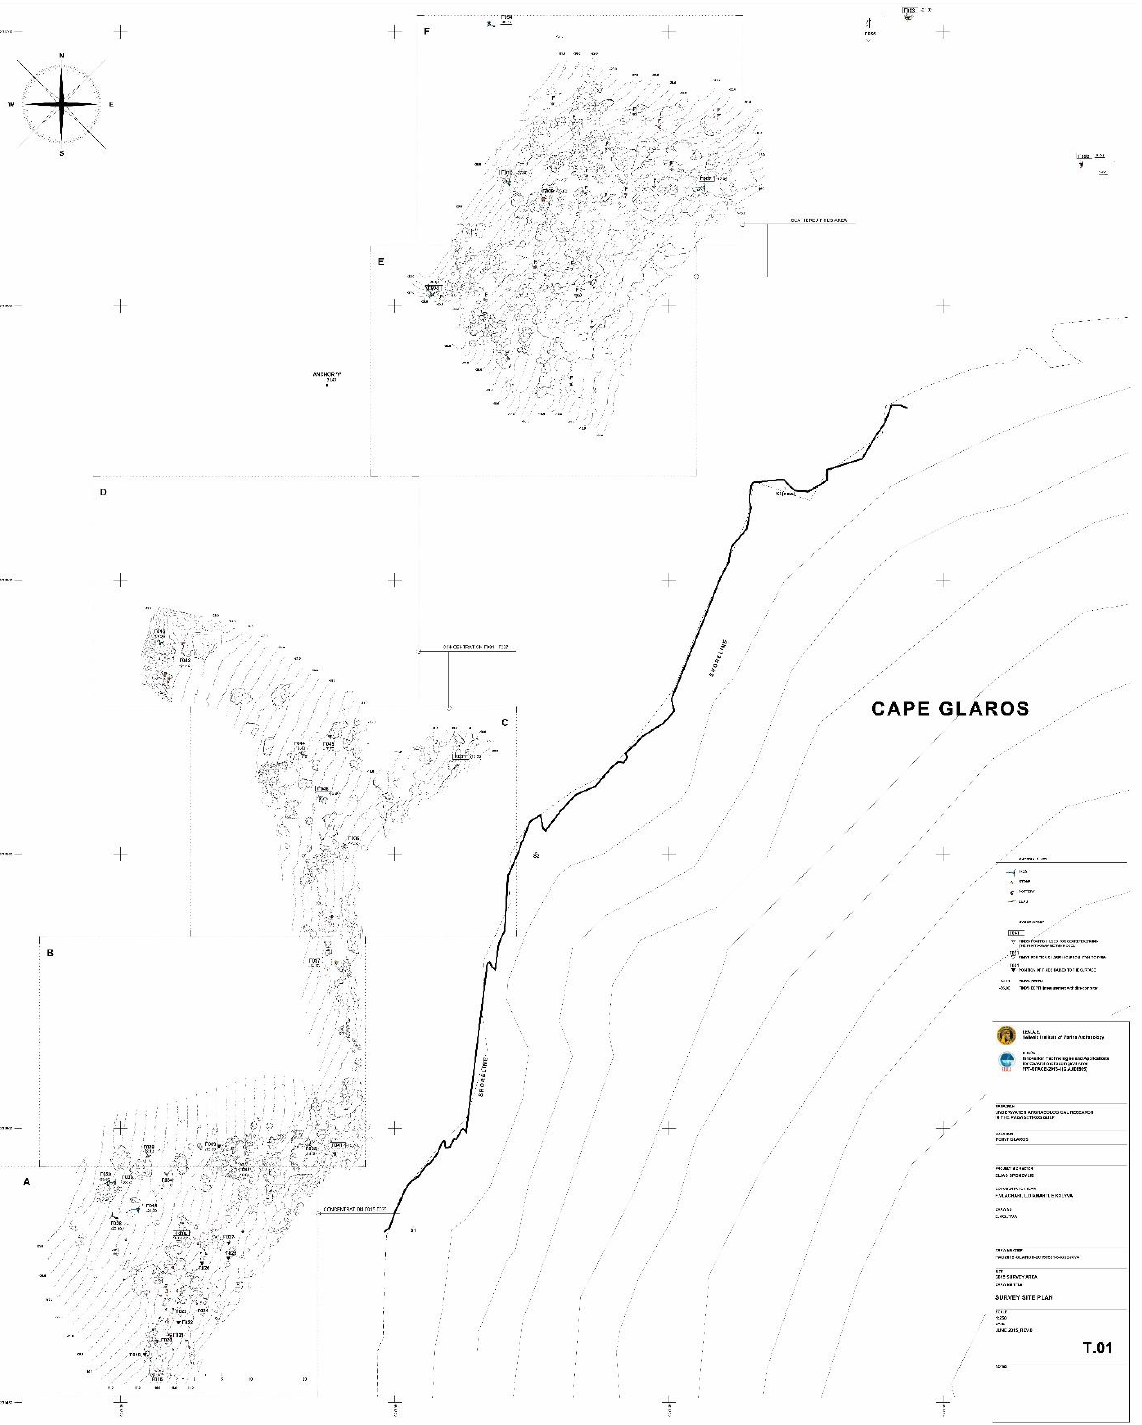
Figure 13: Site plan of Survey Area 2015 (©IENAE